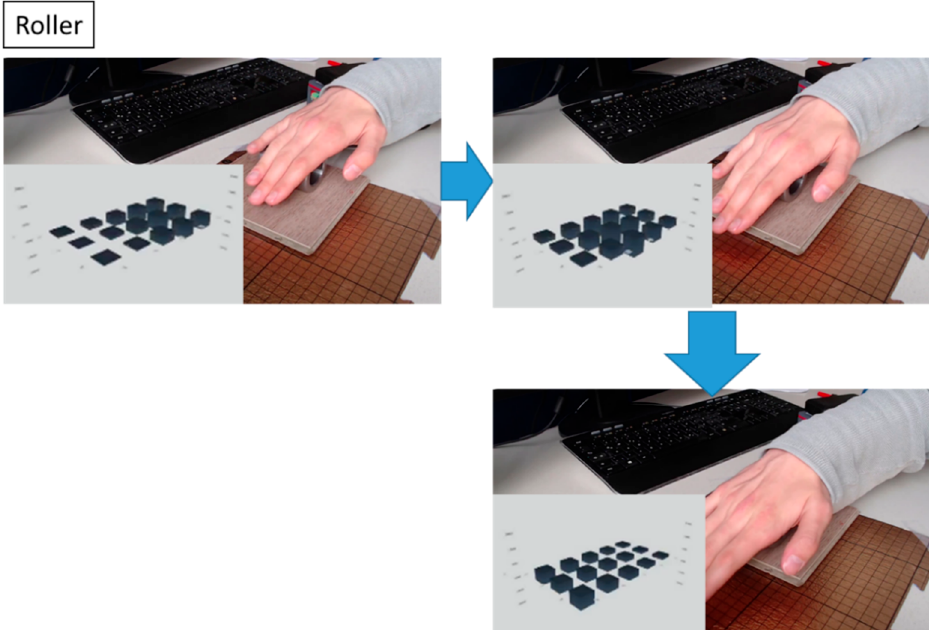
Figure 11. Testing of the sensor matrix with a roller moving over the matrix using the demonstration setup. The insets show the individual pixel responses, as visualized in the GUI. The matrix can clearly capture the movement of the roller. It also shows how the localized pressure applied by the roller on top of the floor spreads laterally in the sensor layer, thus creating a crosstalk between pixels. In this situation, a less dense matrix design could achieve a similar resolution with a reduced material effort and thus costs of fabrication. The established smart floor model helps optimize the pixel density for the individual use cases. The full video is available in the Supplementary Information (Video S1) together with other tested scenarios.